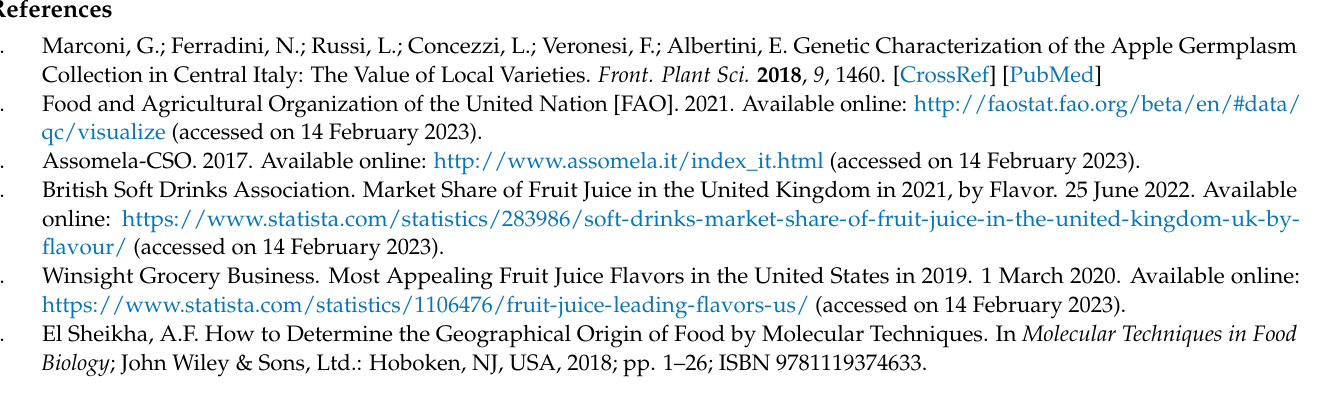
mixed juices. Figure S3: Melt curves (A) and temperature-shifted difference curves (B) of HRMA of trnL (UAA) intron on apple and peach mixed juices. Figure S4: Melt curves (A) and